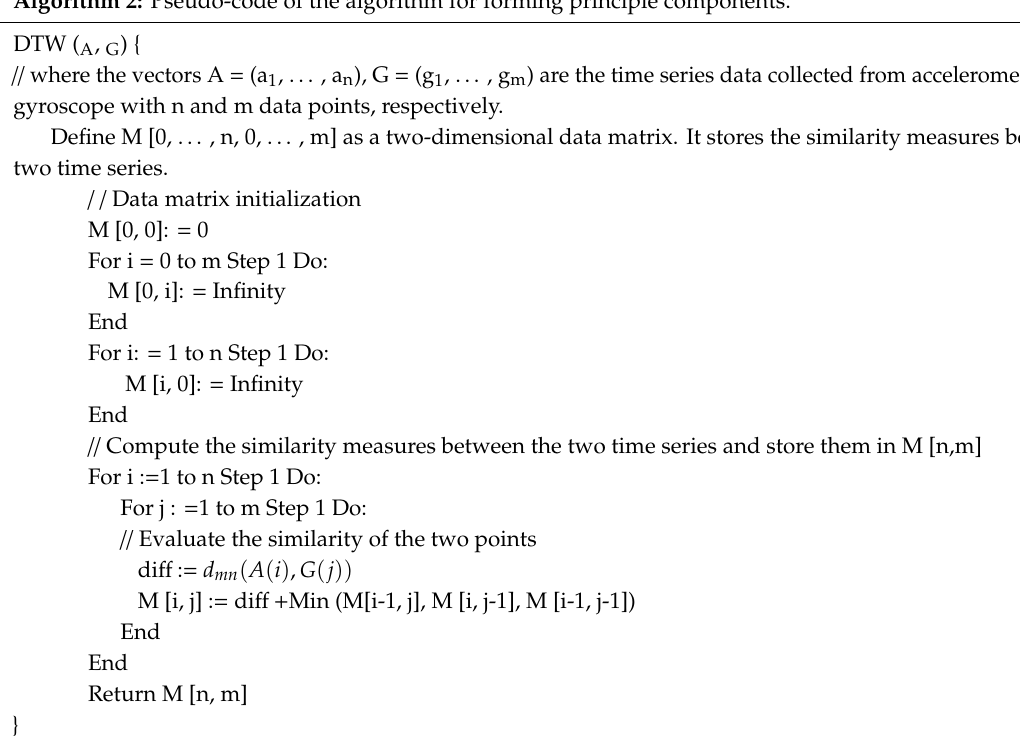
... , a = (g ... , g n ), G m ) are the time series data collected from accelerometer and 1 , 1 ,